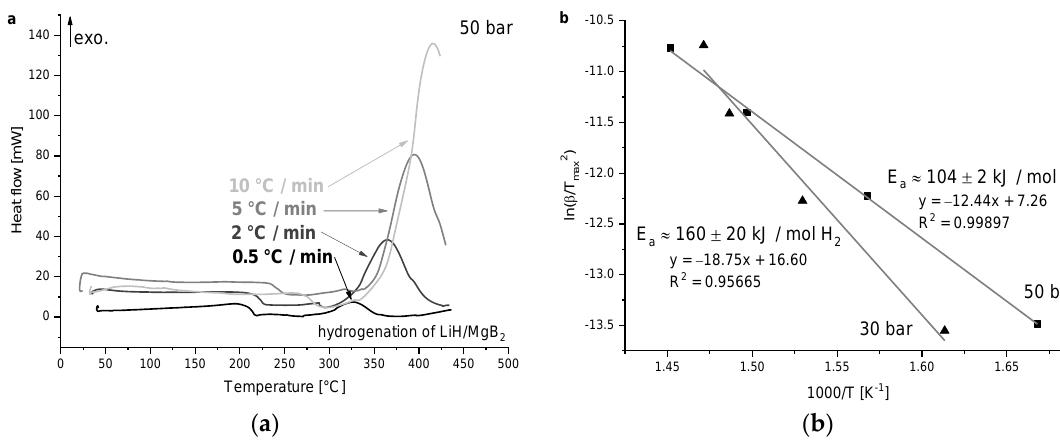
Figure 1. ( a ) Heat flow signal plotted vs temperature for four different heating rates at 50 bar of H 2 (absorption conditions) for the hydrogenation of LiH/MgB 2 ; ( b ) The resultant Kissinger plot as well as the Kissinger plot for the hydrogenation at 30 bar.